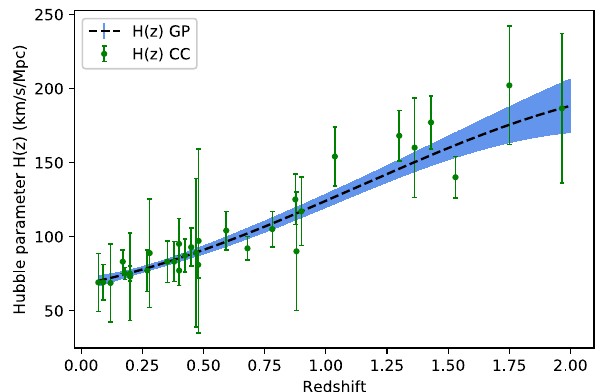
Fig. 6 31 measurements of the cosmic curvature parameter Ω k from the standard sirens of GW space-based detector DECIGO and cosmic chronometers. Inset in the upper right reveals more details